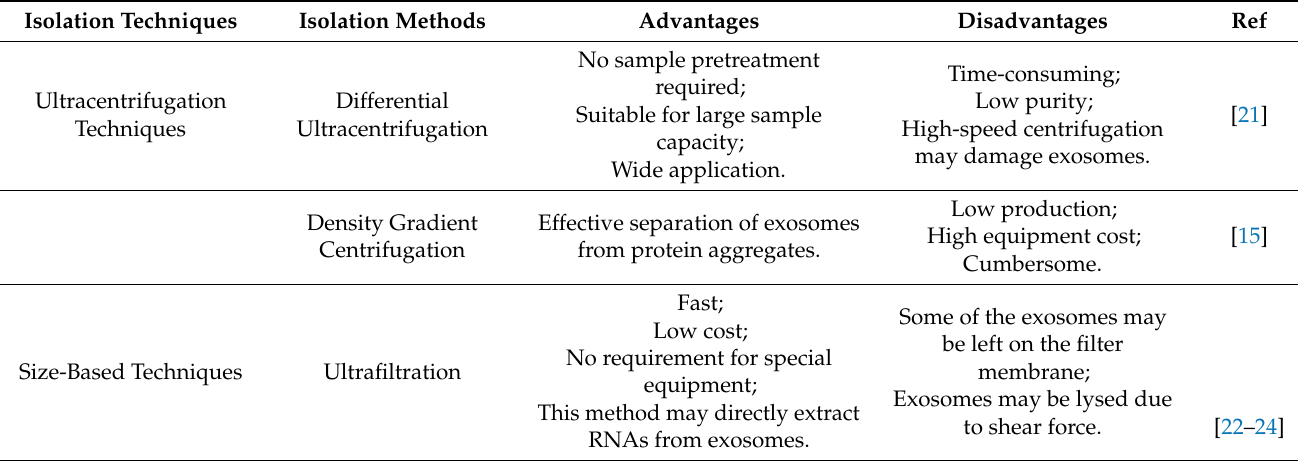
Figure 2. Different components of exosomes. There are various proteins on the surfaces of or inside exosomes, such as membrane fusion proteins, cytoskeleton proteins, tetraspanins, integrins, transmembrane molecules, antigen presenting proteins, costimulatory molecules, MVB formation proteins, enzymes and heat shock proteins. Lipids and RNAs are also enriched on the surfaces of or inside exosomes. These components can mark exosomes or participate in the transport of exosomes for cell–cell communication. Table 1. Comparison of the existing isolation methods for